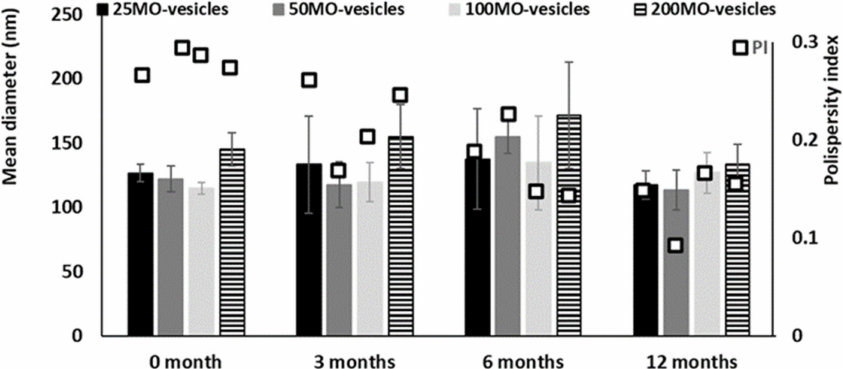
Figure 3. Mean diameter and polydispersity index of vesicles loading quercetin (15 mg/mL) and increasing amounts of mint oil (25, 50, 100 and 200 mg/mL) and stored for 12 months at 25 ◦ C. Mean values (bars) ± standard deviations were reported ( n = 3).